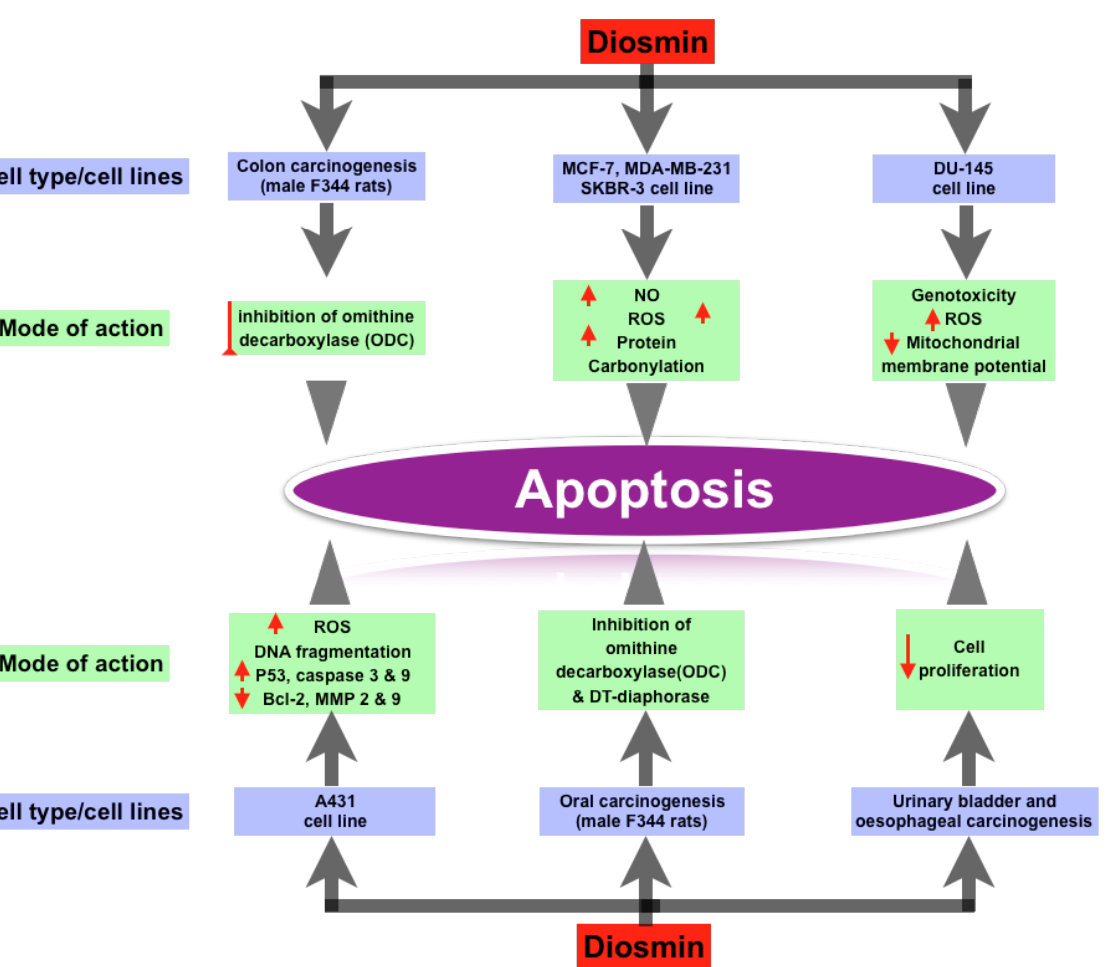
Figure 2. Effect of Diosmin on different types of cancer cell lines and their mode of actions.